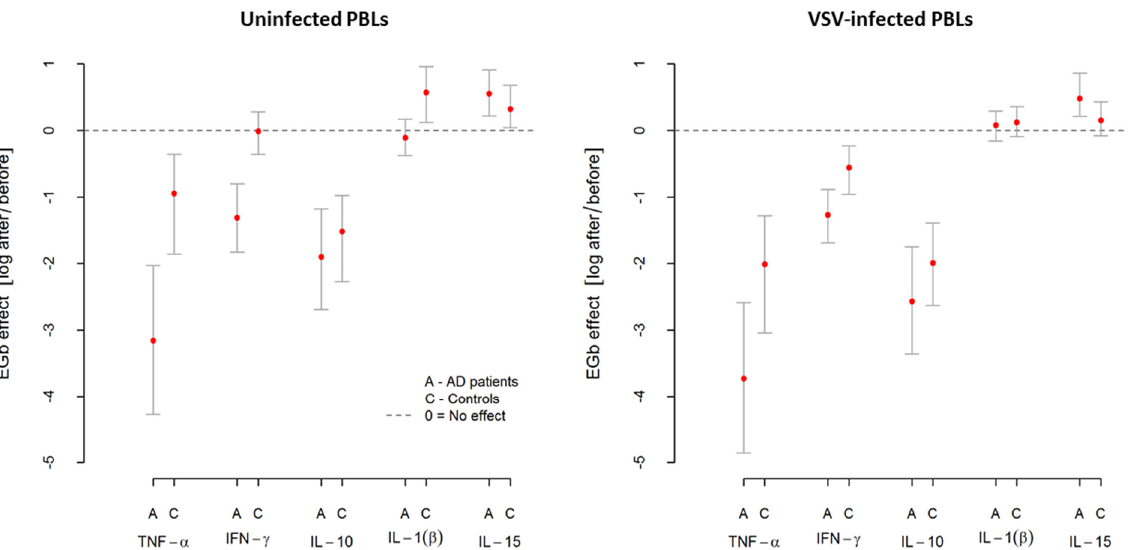
Figure 4. Changes in relative expression of inflammatory-associated genes after EGb treatment in uninfected and VSV-infected PBLs from AD patients and healthy age-matched controls. EGb effect was measured as natural logarithm of ratio after/before gene expression. Zero means no effect. Points represent average change after treatment with confidence interval CI95% for the average.